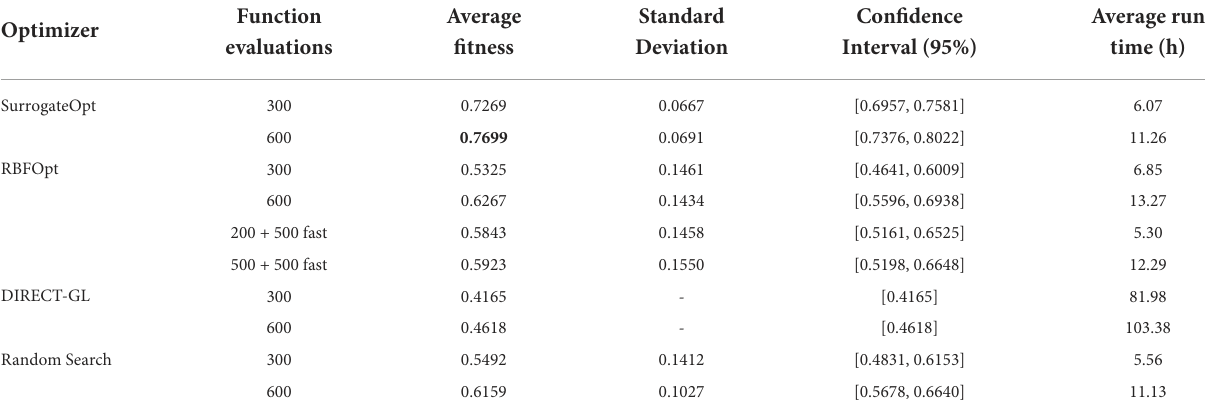
TABLE 3 Performance metrics for each optimizer and configuration considered computed with the results of 20 independent executions.